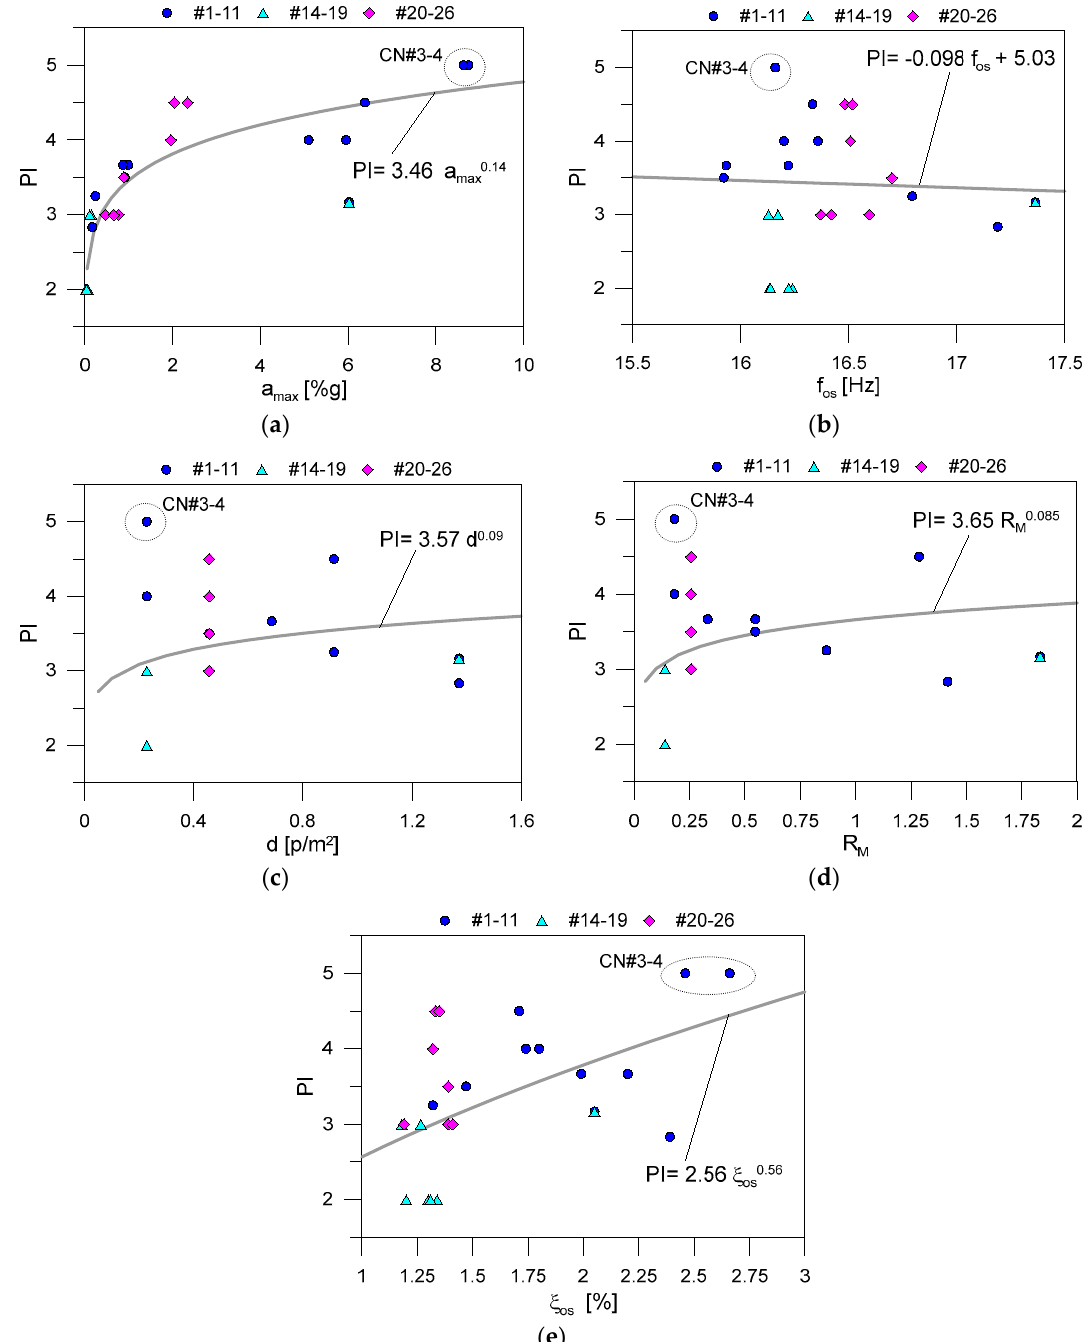
Figure 14. Perception Index (PI) values for the examined system, as a function of ( a ) acceleration peak a max ; ( b ) frequency f os ; ( c ) occupation density d ; ( d ) added mass ratio R M ; ( e ) damping ξ os .